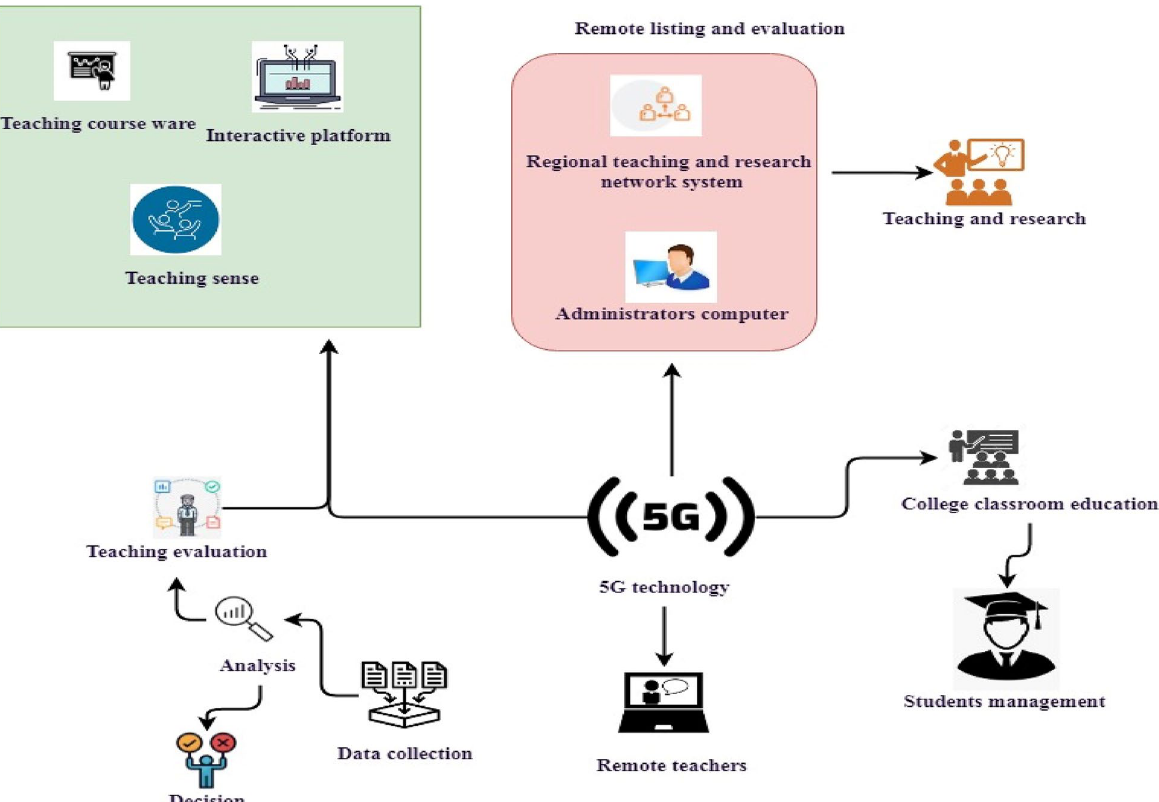
Fig. 5 5G wireless communication in teaching quality evaluation of college classroom